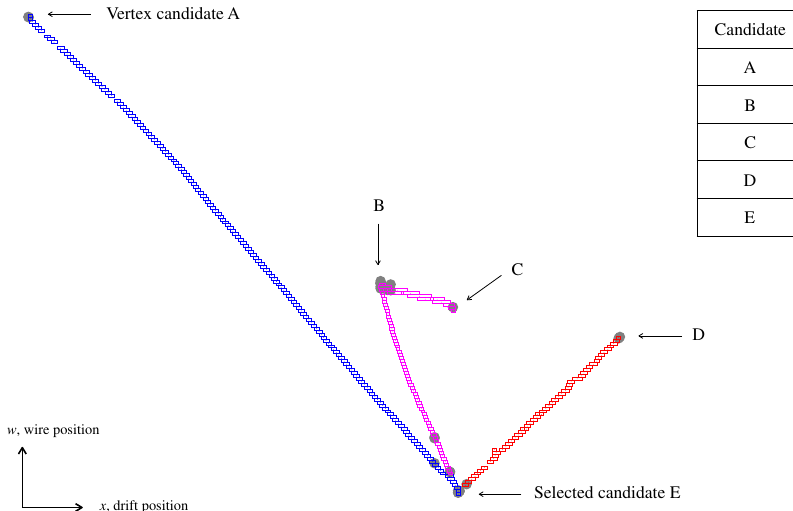
Fig. 5 The positions of 3D neutrino interaction vertex candidates, as projected into the w view. A comprehensive list of candidates is pro- duced for each event, identifying all the key features in the event topol-